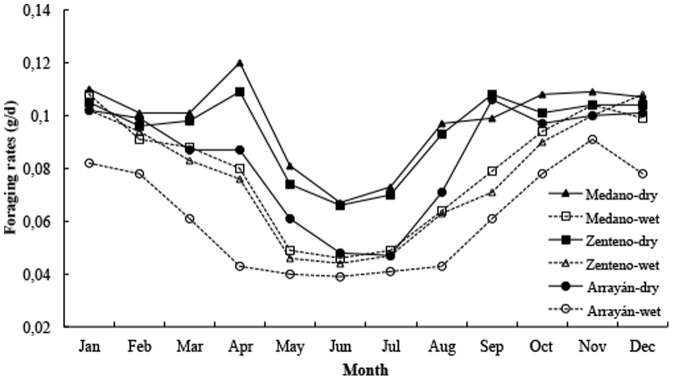
Foraging rates for lizards from Medano, Zenteno, and Arrayán on dry (terrestrial, filled symbols) and wet (intertidal, empty symbols) conditions.